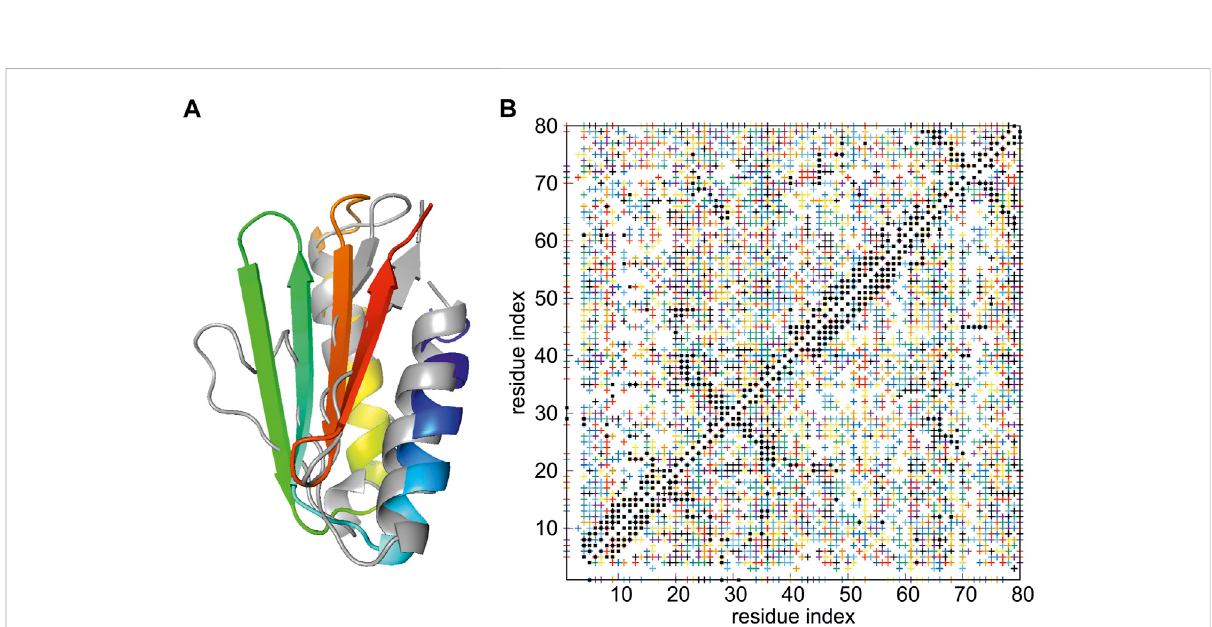
FIGURE 4 (A) Superpositionofthebestmodelofthestructureof denovo designedFoldit3proteinsimulatedwithNMR-data-assistedUNRES,usinghighly ambiguousdistance restraints (gray), and the experimental 6msp structure (colored from blue to red from the N- to the C-terminus). The RMSD and GTD_TS values are 3.87 Å of 64.06, respectively. (B) The proton-proton contacts in the calculated structures (black squares) superposed on those found from NMR experiments (colored crosses, each color corresponding to a group of ambiguous